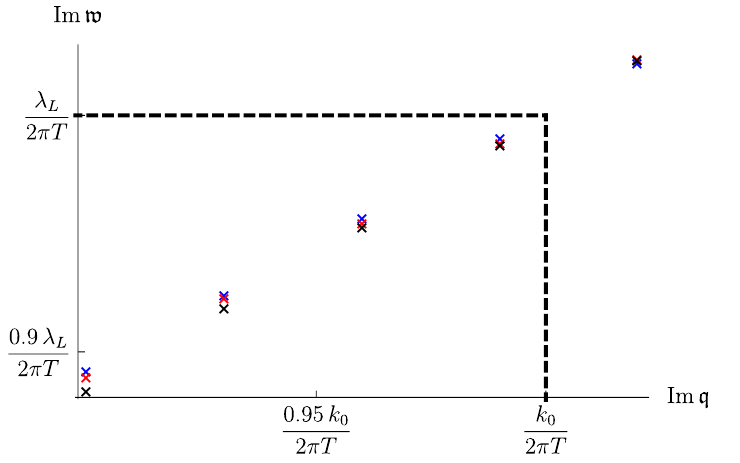
Figure 1 . A plot of the hydrodynamic sound dispersion relation w ( q ) in non-perturbative Einstein- Gauss-Bonnet theory for a choice of three di(cid:11)erent values of (cid:21) blue and red, respectively. We see that for all (cid:21) point of chaos (2.11), as enforced by the phenomenon of